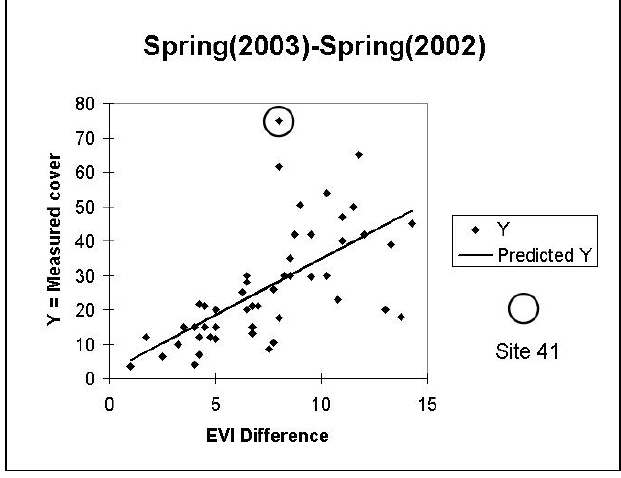
Figure 5. Scatter plot between field-estimated 2003 annual cover and the annual-growth model based on the metric Average Spring (2003)-Average Spring (2002). Site 41 was anomalous because in spring 2003 it had the highest total perennial plus annual coverage of all sites, at 93 %. (Y= Annual Cover, measured in field and predicted).